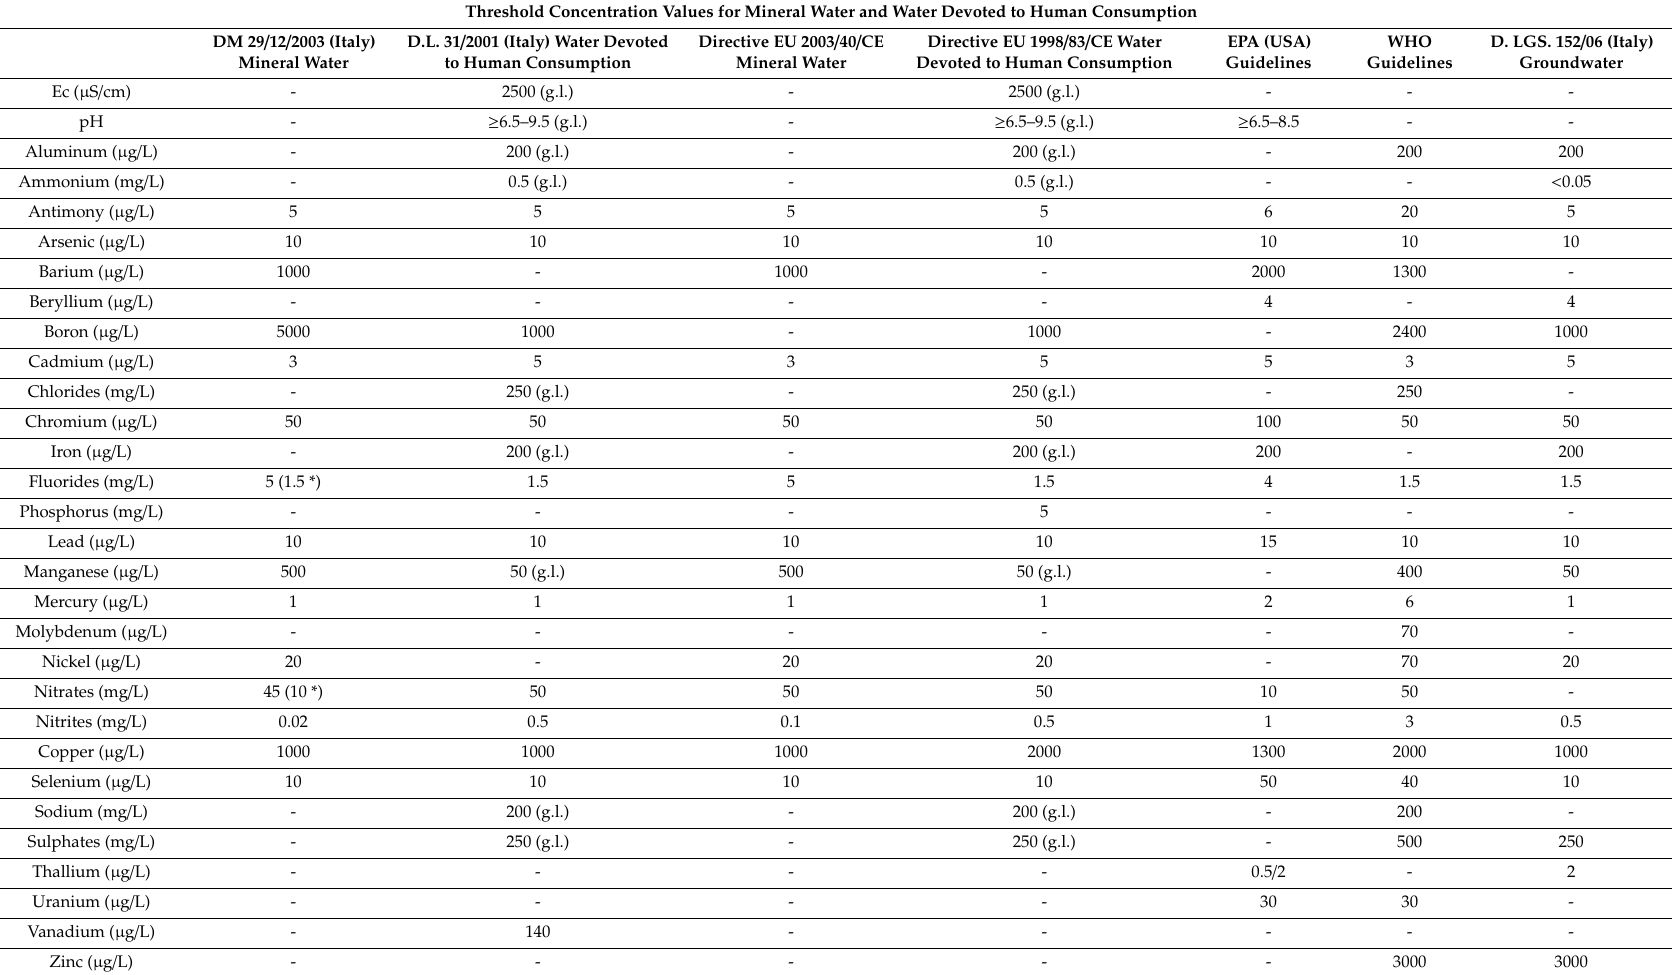
Table 1. Threshold concentration values for mineral water and water devoted to human